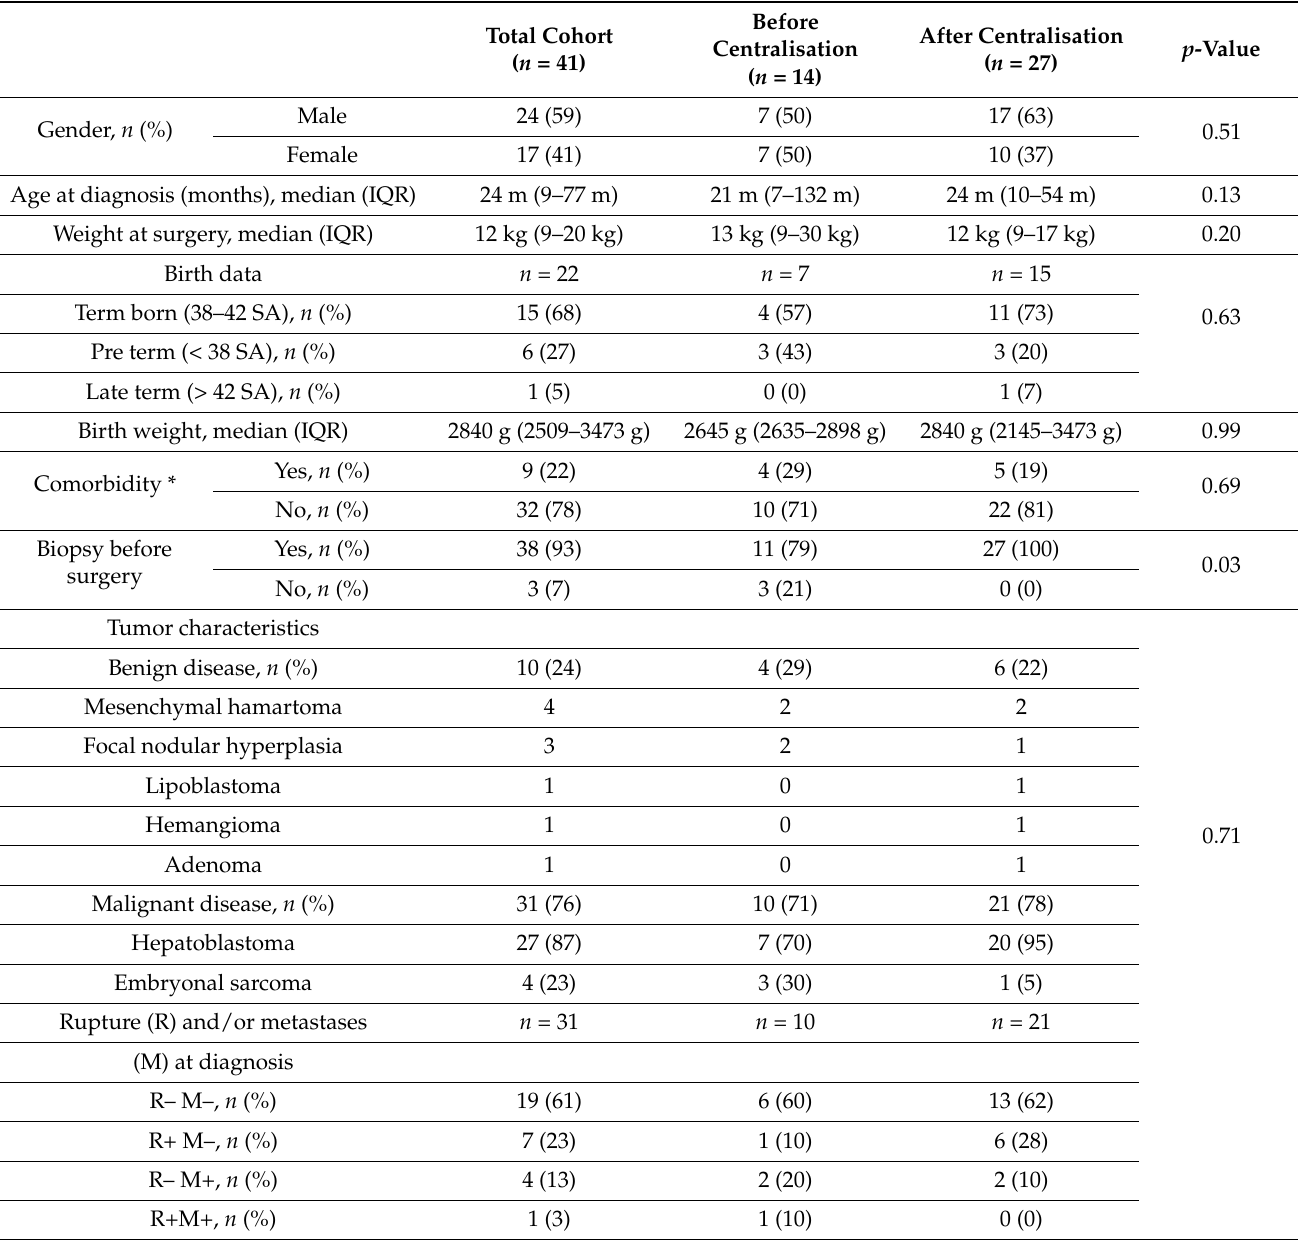
Table 1. Demographic, clinical and pathological characteristics of the study population and the two subgroups. * Beckwith–Wiedemann syndrome (3), neurofibromatosis type 1 (1),